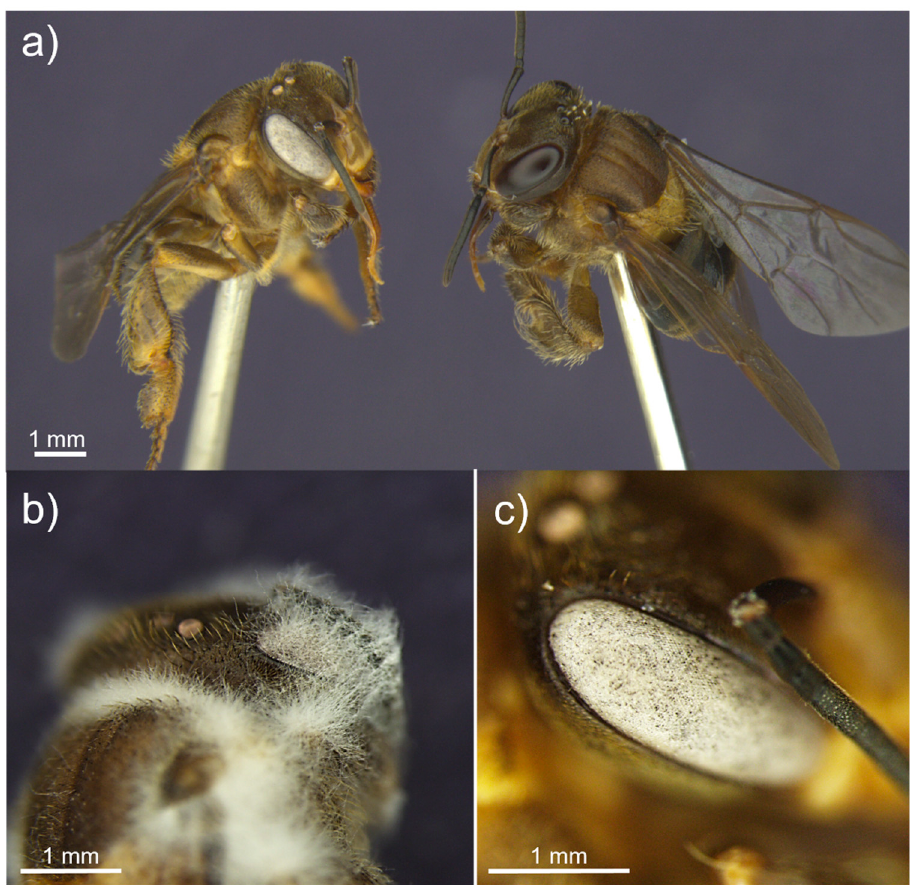
Figure 4. Comparison of the eye color change of a B. bassiana -infected ( left ) and non-infected ( right ) Scaptotrigona depilis ( a ). Detail of a S. depilis dead body with B. bassiana outgrowth ( b ). Detail of the B. bassiana growth inside S. depilis eye ( c ).